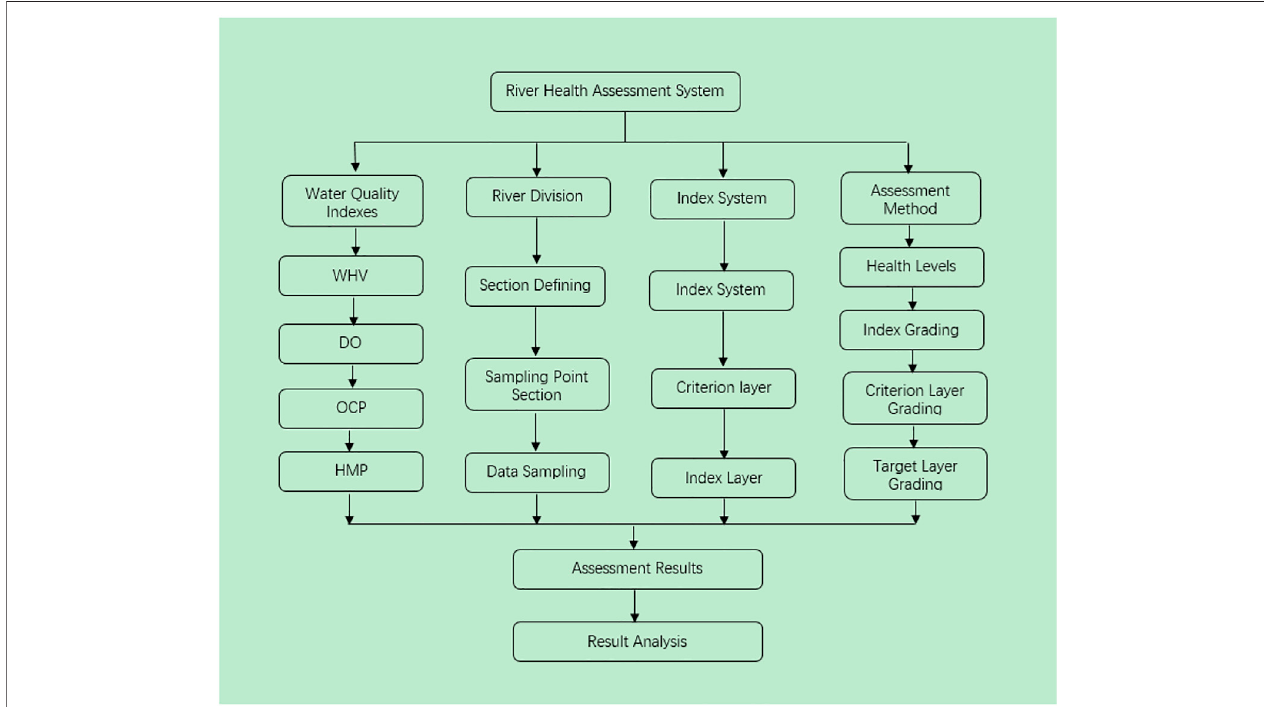
FIGURE 1 | Study content and the technical road of the river health assessment system